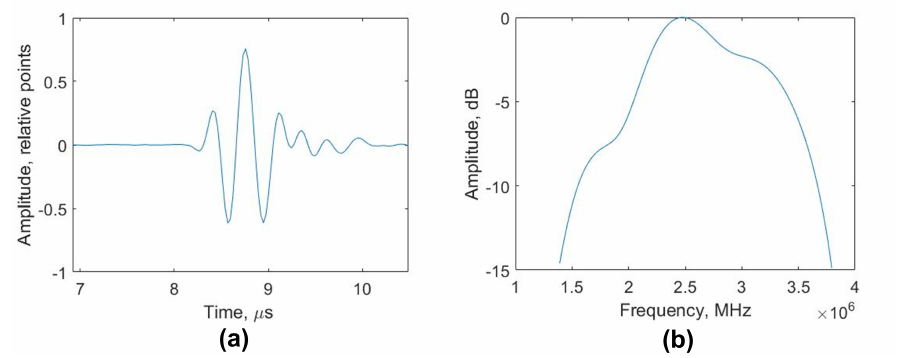
Figure 7. The pulse-echo response of the single PA element from the surface of the testing object (depth 6.5 mm) ( a ) the magnitude of the pulse spectrum ( b ).